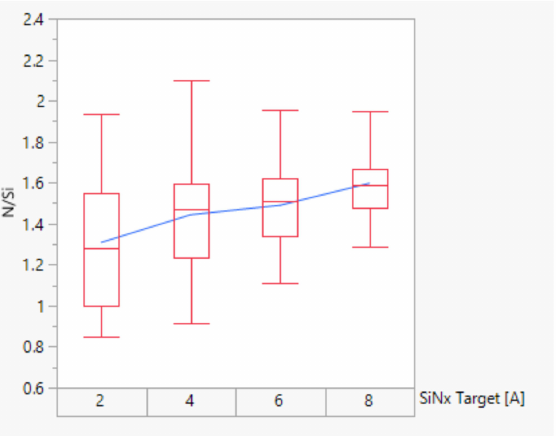
Figure 8. SEM/EDX N/Si ratio as a function of SiN x content in the SiN x